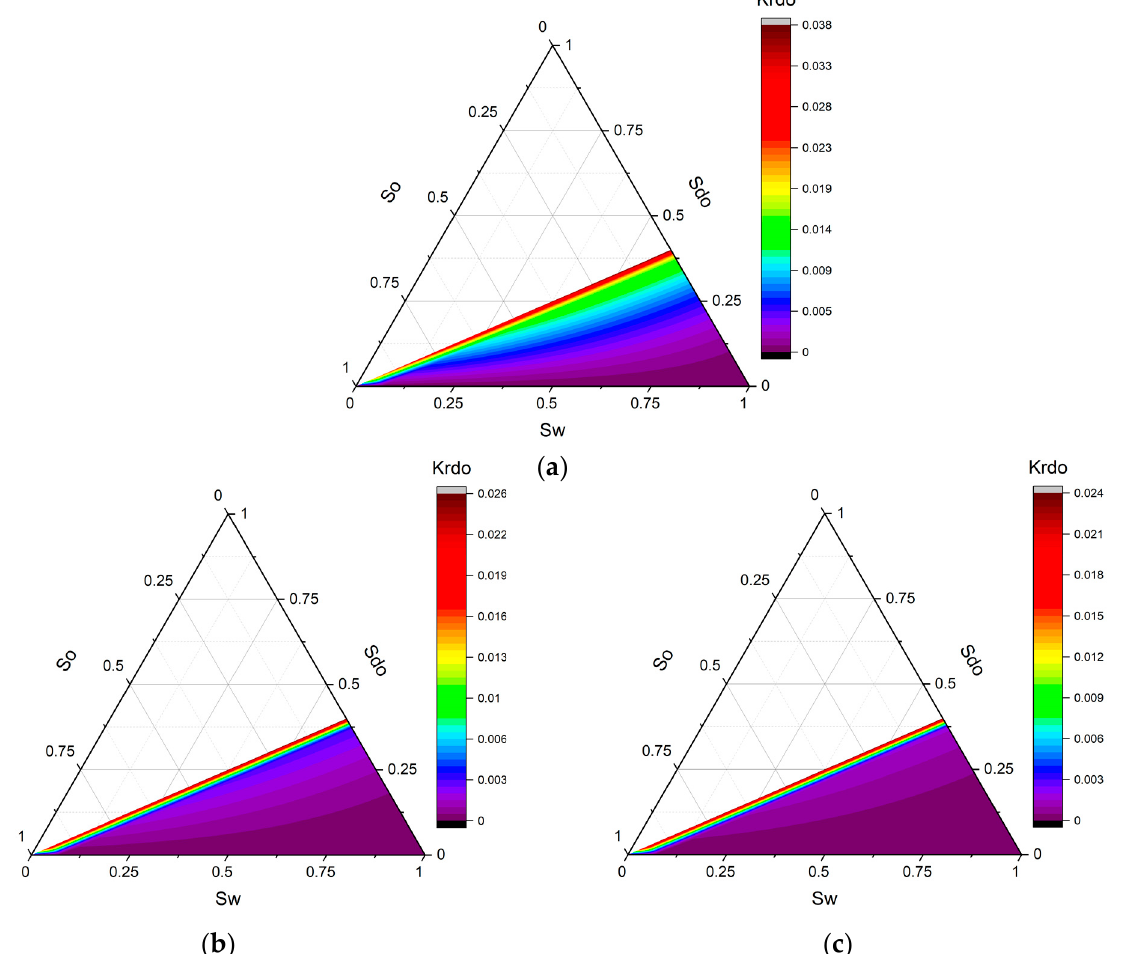
Figure 13. The relative permeability ternary diagrams of the dispersed oil phase with φ d = 0.4, λ = 0.9, and different Ca . ( a ) Ca = 10 − 3 ; ( b ) Ca = 10 − 4 ; and ( c ) Ca = 10 − 5 . Table 1. 𝐾 (cid:3045)(cid:3031)(cid:3042) endpoint values with different dimensionless parameters. = 𝟎. 𝟏 𝝓 𝝓 𝒅 𝒅 = 0.2